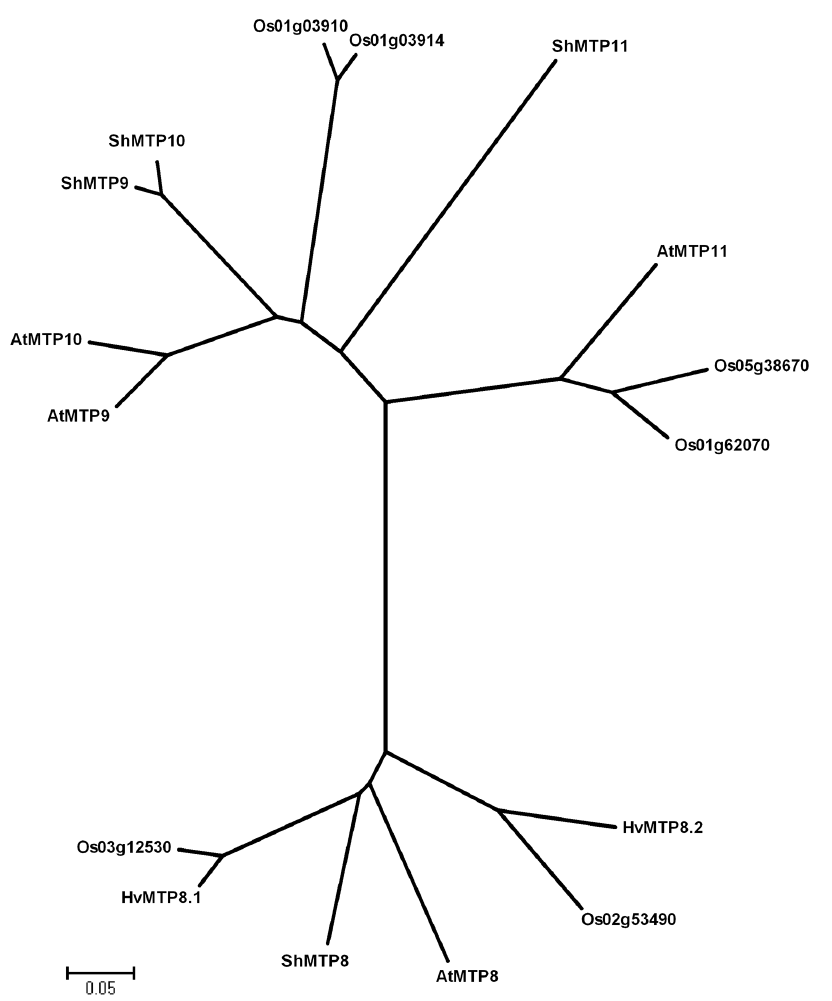
Fig. 1. Phylogenetic analysis of 16 MTP protein sequences from Hordeum vulgare (Hv), Oryza sativa (Os), Arabidopsis thaliana (At) and Stylosanthes hamata (Sh). Alignment of full-length sequences was done as described for S1 Figure. The phylogenetic tree was drawn with the MEGA version 4.0 (http://www. megasoftware.net) [59]. Numbers represent bootstrap values for 1000